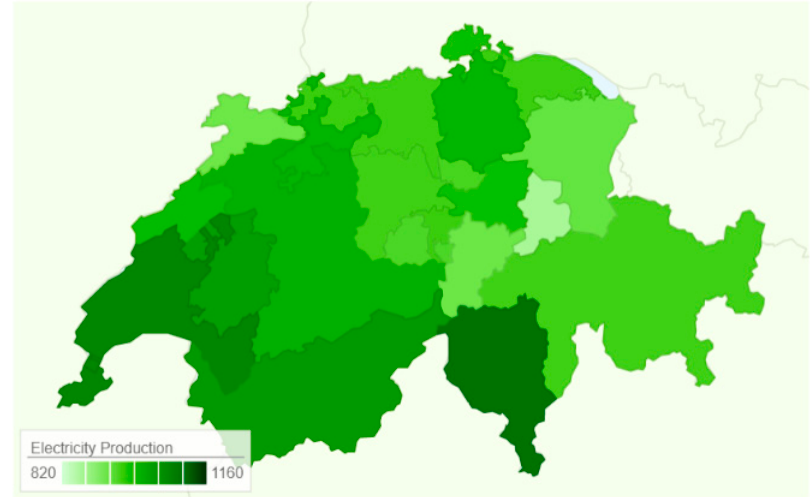
Figure A1. Expected annual electricity production from 1 KWp rooftop solar PV system in each Canton in kWh/yr. (own illustration based on [45]).